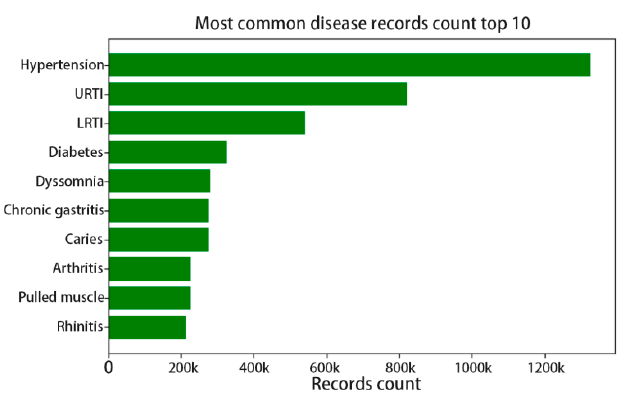
Figure 1. The top 10 disease record count distributions. Figure 1. The top10 disease record count distributions. Figure 1. The top10 disease record count distributions.